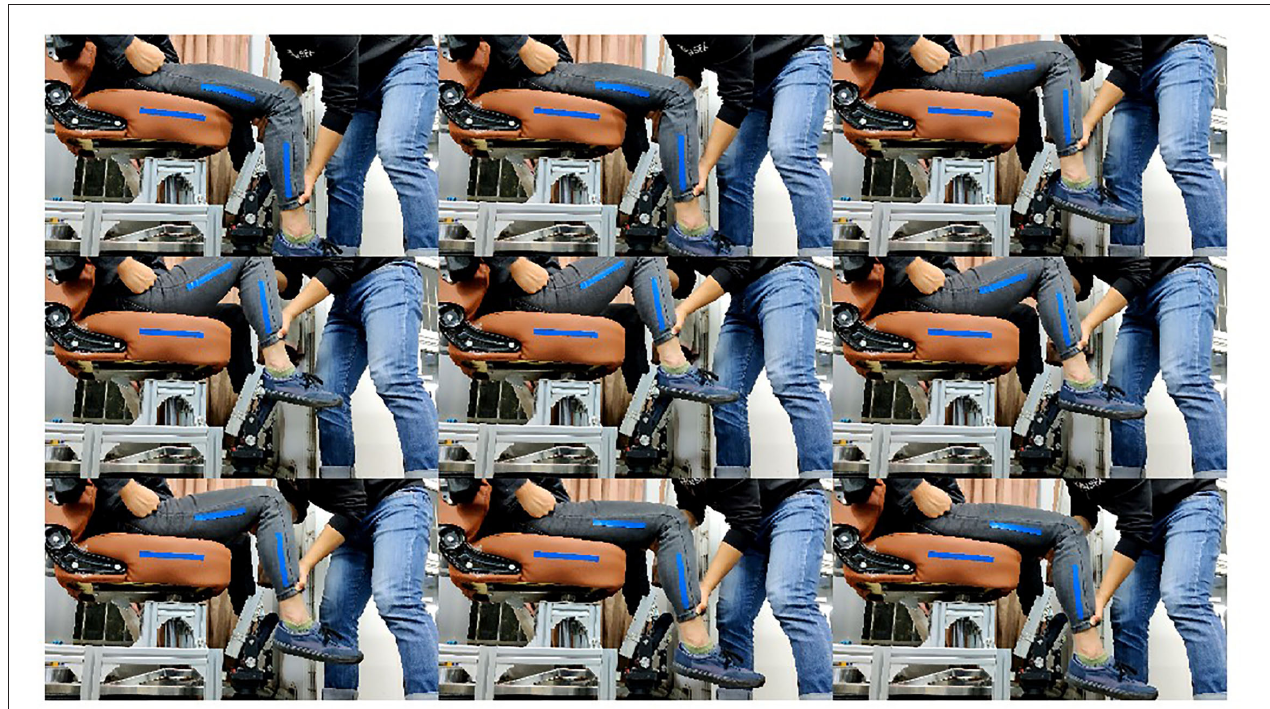
FIGURE 5 | Measurement of the hip joint range of motion in the sagittal